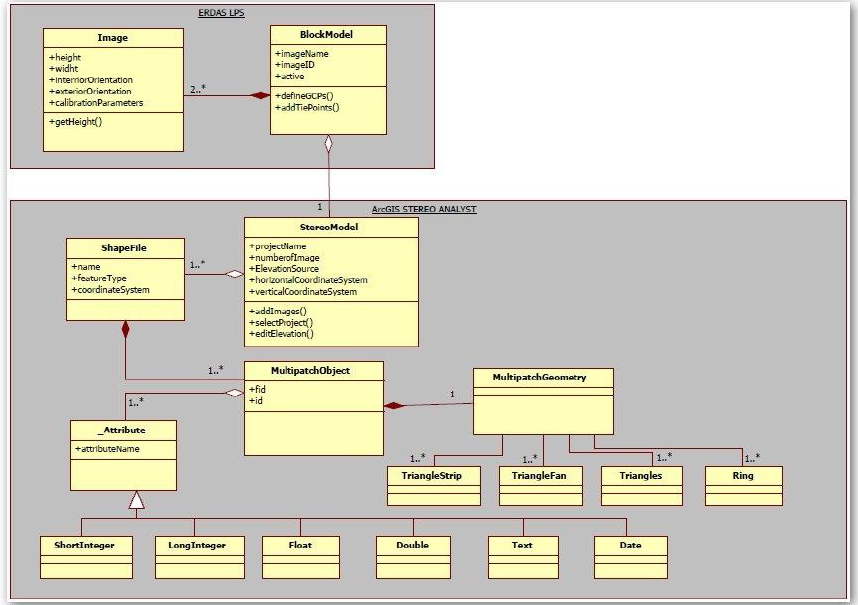
Figure 3.1: Overview UML diagram of Photogrammetric Tool’s Building Model